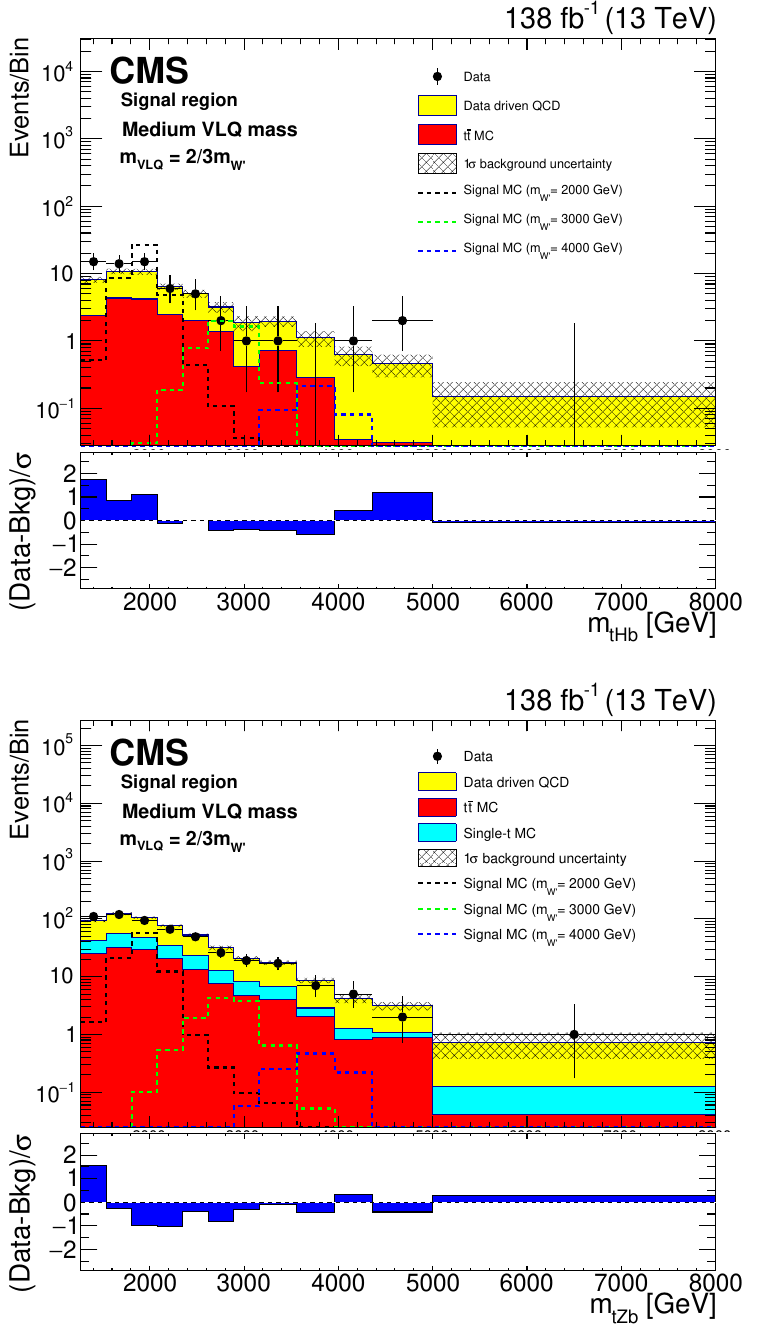
distributions ( m (upper), and m (lower)) in the signal region Figure 6 . Reconstructed m tHb tZb W 0 with estimated backgrounds and signal for several W 0 boson mass hypotheses, after a background- only fit. The combined statistical and systematic uncertainty in the total estimated background is indicated by the hatched region. The lower panels show the difference between the number of events observed in the data and the predicted background, divided by the total uncertainty in the background and the statistical uncertainty in the data added in